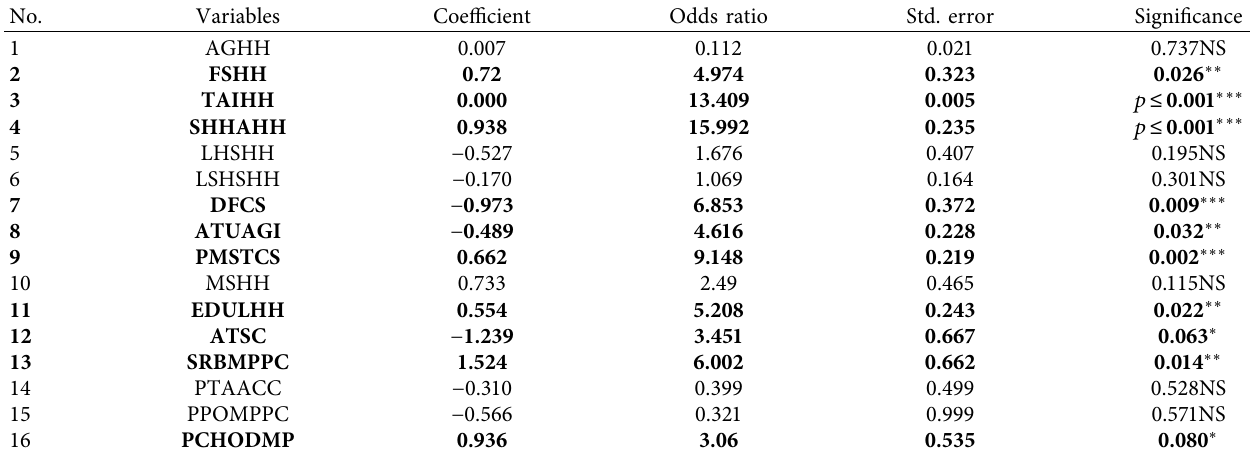
Table 15: Result of ordered logit model